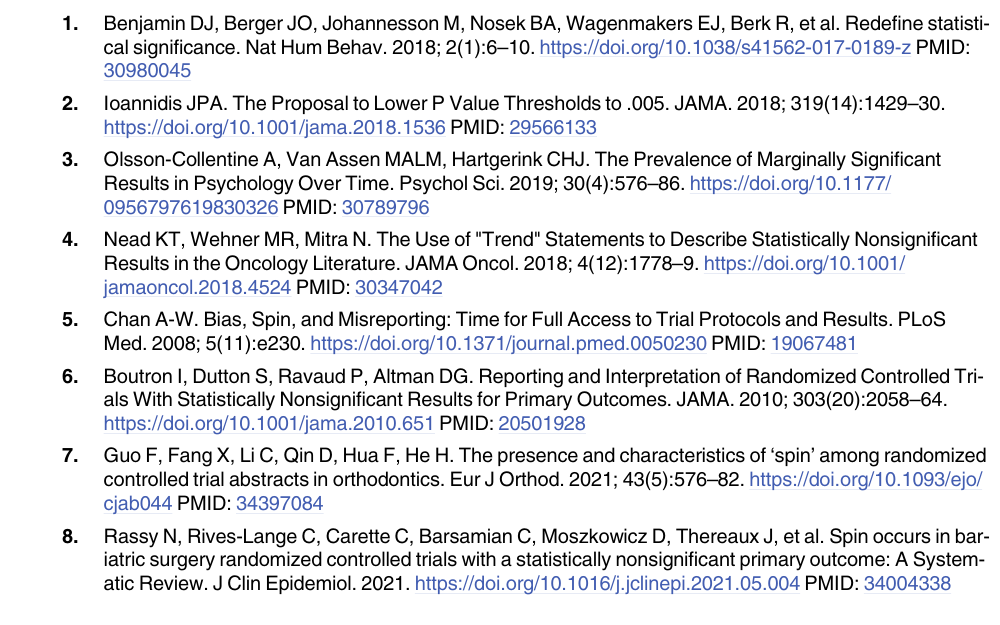
S3 Table. All extracted P values within the 3 range categories, as the proportion of the total of 11,926